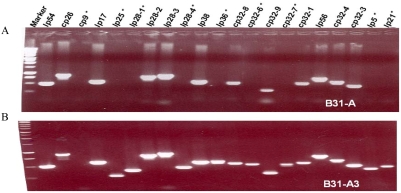
PCR analysis of plasmids in strains B31-A and B31-A3.Twenty-one pairs of specific primers were used to amplify all the circular and linear plasmids contained in the two strains. DNA markers (left lane) identify the sizes of amplified DNAs. “*” indicates the plasmids that are lost from B31-A strain. A) B31-A is missing lp25, lp28-1, lp28-4, lp36, cp32-6, cp32-7, lp5 and lp21, in addition to cp9. B) B31-A3 retains all twenty one plasmids except cp9, as expected [22].